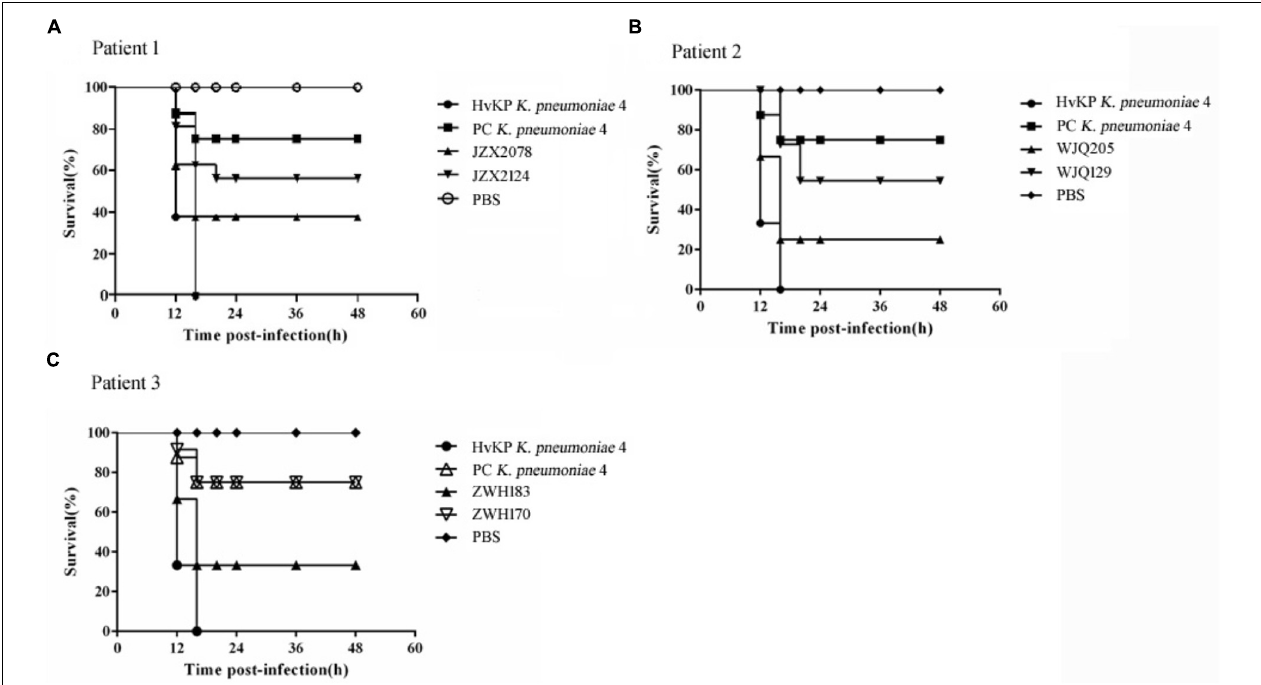
FIGURE 5 | Virulence potential of KPC-2-producing CRKP isolates from Patient 1 (A) , Patient 2 (B) and Patient 3 (C) in the G. mellonella infection models. The effect of 1 × 10 6 CFU of each K. pneumoniae strain on survival was assessed in G. mellonella . HvKP strain K. pneumoniae 4 was a ST11 KPC-producing hypermucoviscous strain harboring various virulence genes, located on the virulence plasmid pLVPK. Strain PC K. pneumoniae 4 is a mutant strain of K. pneumoniae 4, of which the virulence plasmid has been removed in plasmid curing experiments. Strain PC K. pneumoniae 4 was negative for string test and demonstrated reduced virulence in G. mellonella